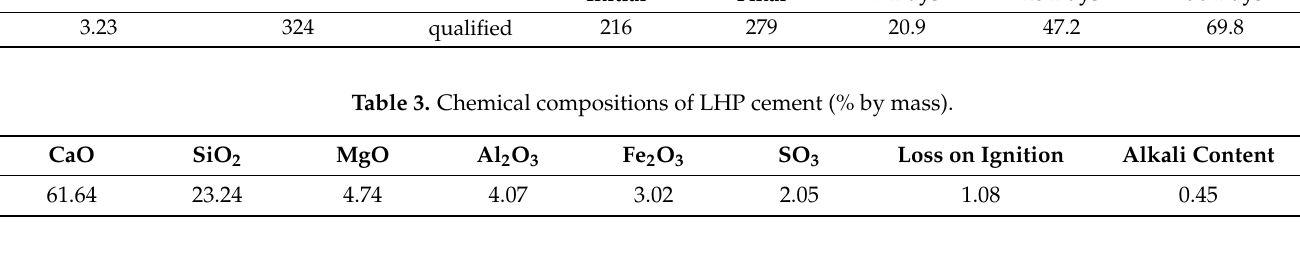
Table 4. Physical properties of fly ash.